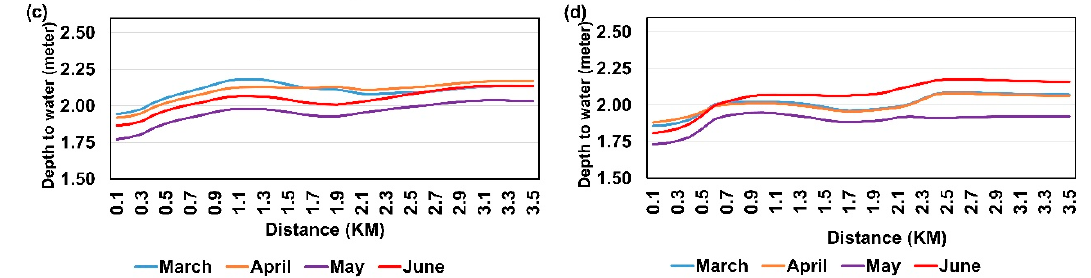
Figure 7. Variation of depth to water along the gradient of the study area: ( a ) northern zone, ( b ) eastern zone, ( c ) southern zone, and ( d ) western zone.